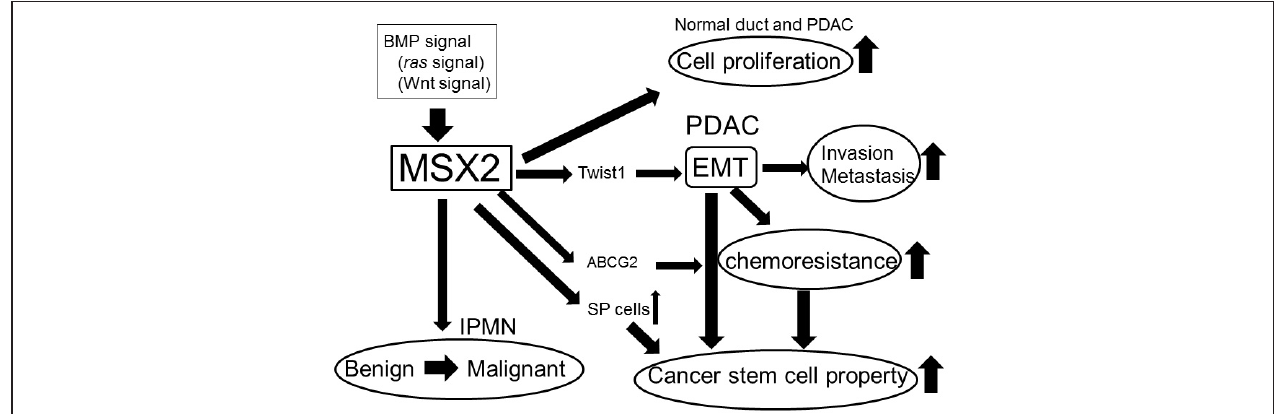
FIGURE 1 | Summary of the roles of MSX2 in pancreatic tumor